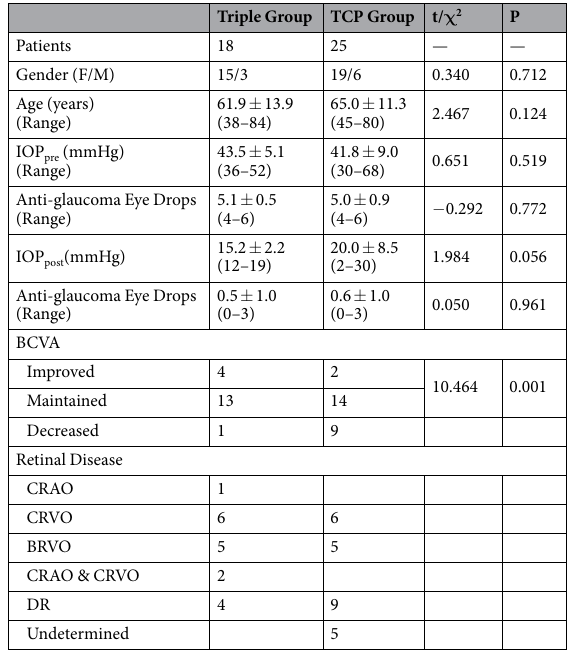
Table 1. The results and demographic characteristics of the triple sequential therapy group and TCP groups. BCVA, best corrected vision acuity; BRVO, branch retinal vein occlusion; CRAO, central retinal